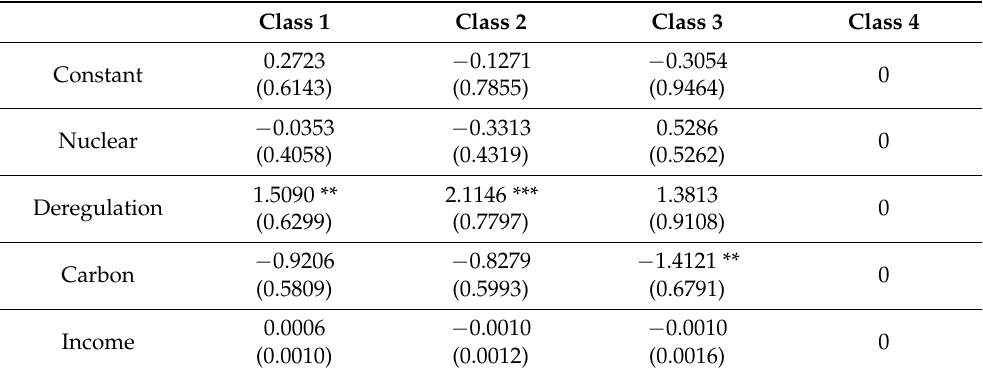
Table 4. Membership